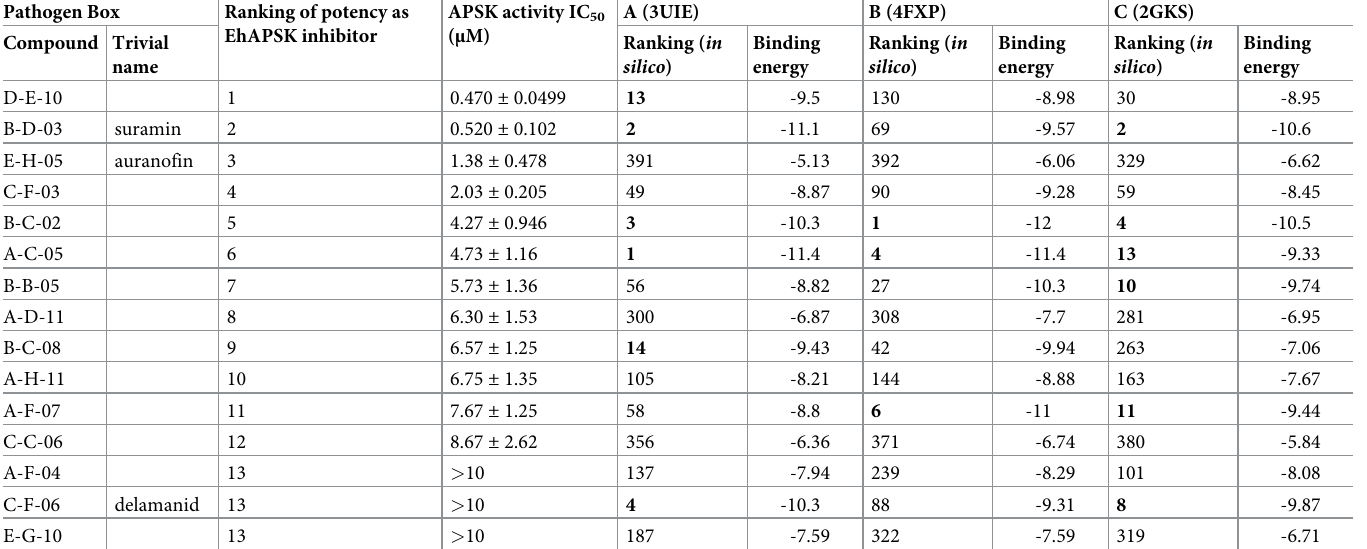
Table 2. Comparison of results from in vitro activity assay and in silico docking analysis. Ranking ( in vitro ) was based on IC 50 values, which were determined by more than three independent experiments and expressed as average ± SD. Ranking ( in silico ) is from S2 Table. A-D-11, A-H-11, and E-H-05 used for IC 50 determination were from commercial sources whereas the other 12 compounds were from the Pathogen Box. A, EhAPSK structure-A; B, EhAPSK structure-B; and C, EhAPSK structure-C. PDB IDs shown inside parentheses indicate the template tertiary structures used for generating the homology modeling EhAPSK structures. Pathogen